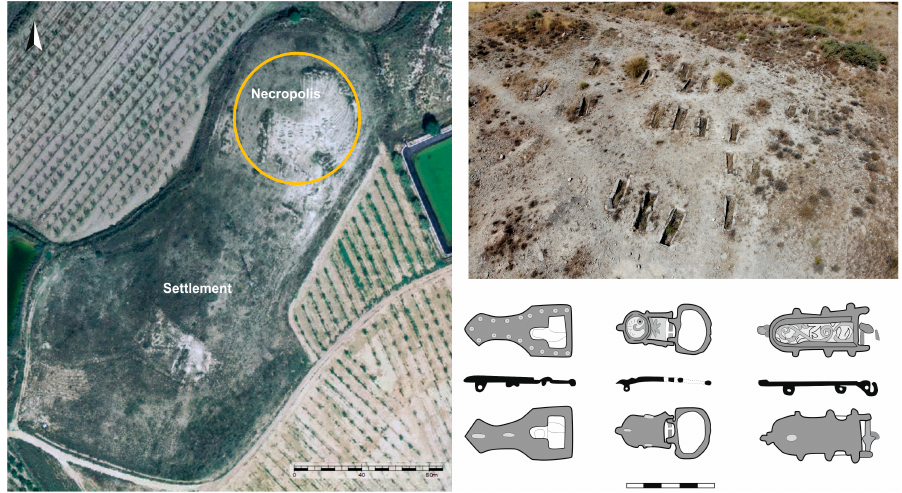
Figure 5. An orthophoto of the hill where the village of Loma Eugenia (LE) was installed. The right-hand side of the necropolis was partially excavated in 1995, which is where the belt buckles were found.